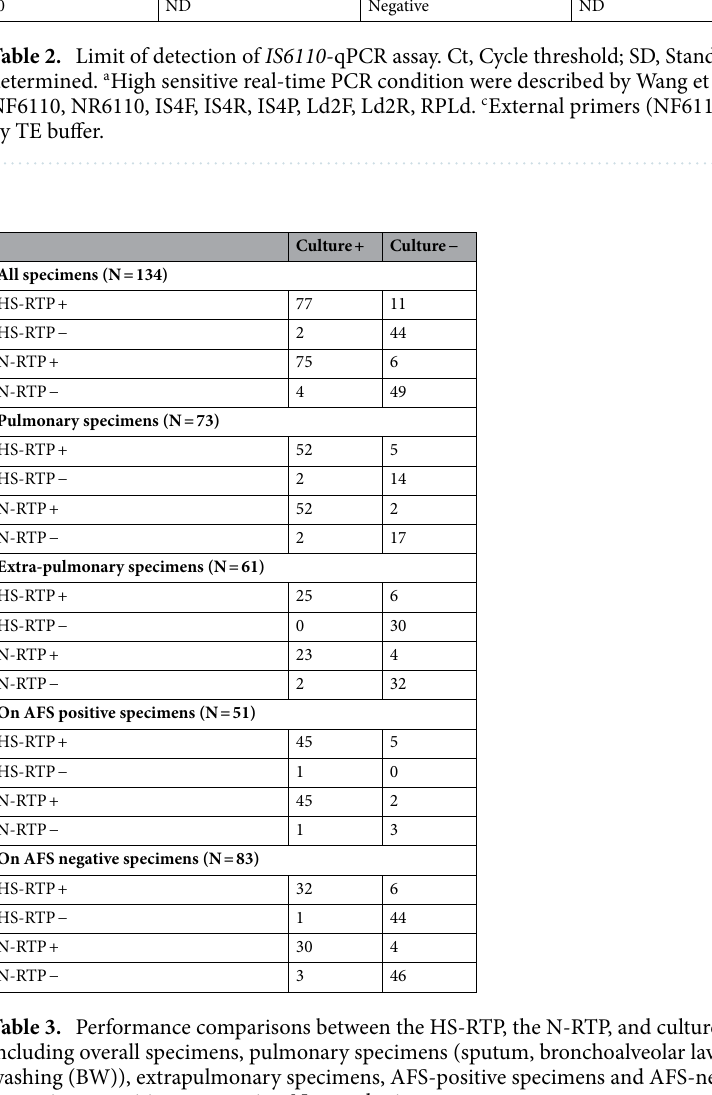
supplemental Fig. 1. Two and one single-nucleotide polymorphisms occurred in M. africanum and M. canettii , respectively. The IS1081 DNA sequence shares 99.9% identity with MTBC, which is similar to the result for the IS6110 sequence and meets our expectations. In addition, we designed a new outer primer (Nes1081) and inner primer/probe set (IS1081F, IS1081R and IS1081P) for IS1081 nested PCR in this study. To verify the perfor- mance of IS1081 nested PCR amplification, the sensitivity of the primer and probe set was investigated using the method described previously. The IS1081 amplicon was used to design a 6-carboxyl-X-rhodamine (ROX)- labeled IS1081P probe emitting red fluorescence (610 nm). The comparison of HS1081 and N1081 shows that